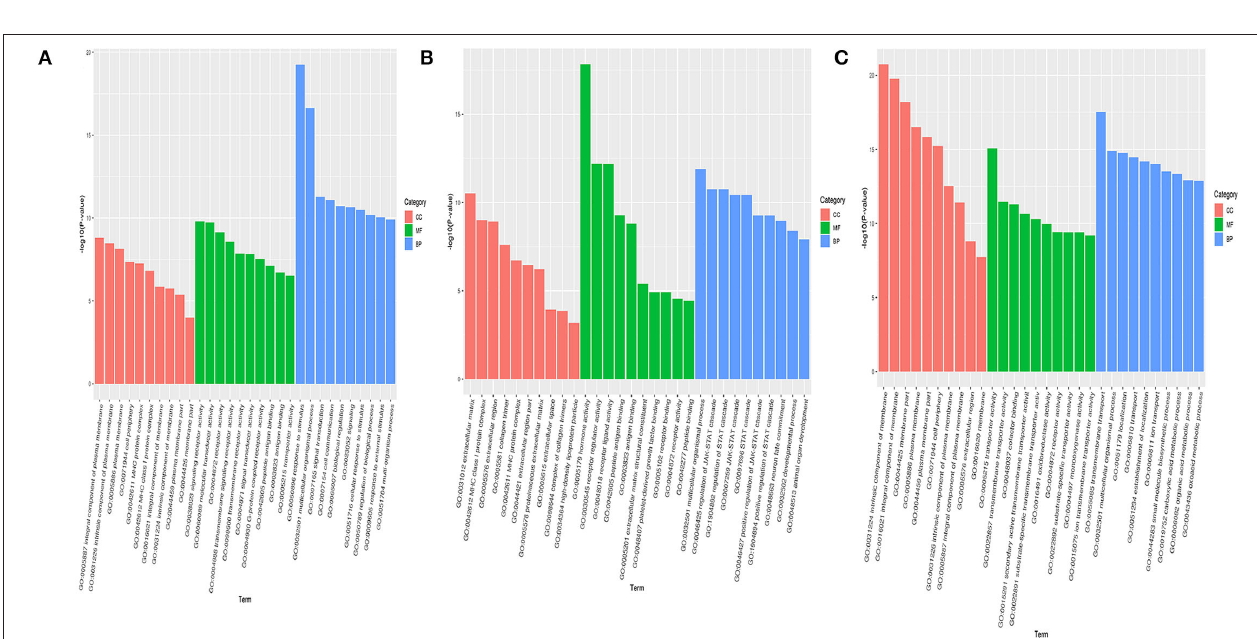
FIGURE 3 | Volcanic map of differentially expressed genes. The abscissa is log 2 (Fold Change) and the ordinate is –log 10 ( P -value). In the figure, the two vertical dashed lines are twice the threshold of expression difference. The horizontal dashed line is the threshold of P = 0.05. Red dots indicate up-regulated genes in this group, blue dots indicate down-regulated genes in this group, and gray dots indicate genes that are not significantly differentially expressed.